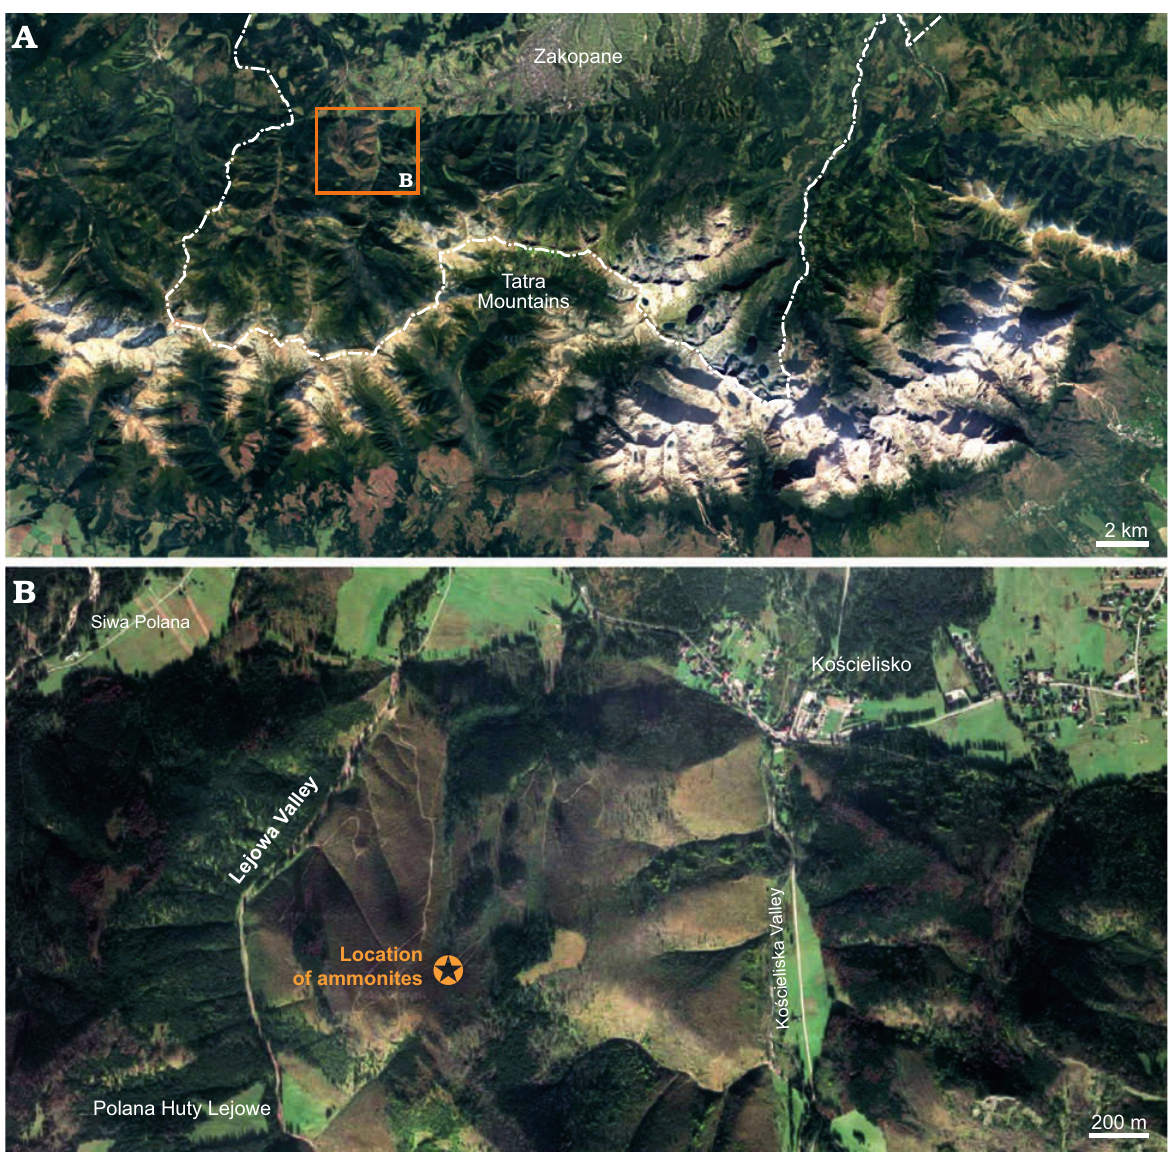
Fig. 1. Location of ammonite collection area (asterisk shows fossil sampling locality, 49°16.109’ N, 19°51.194’ E). Satellite views from the Google